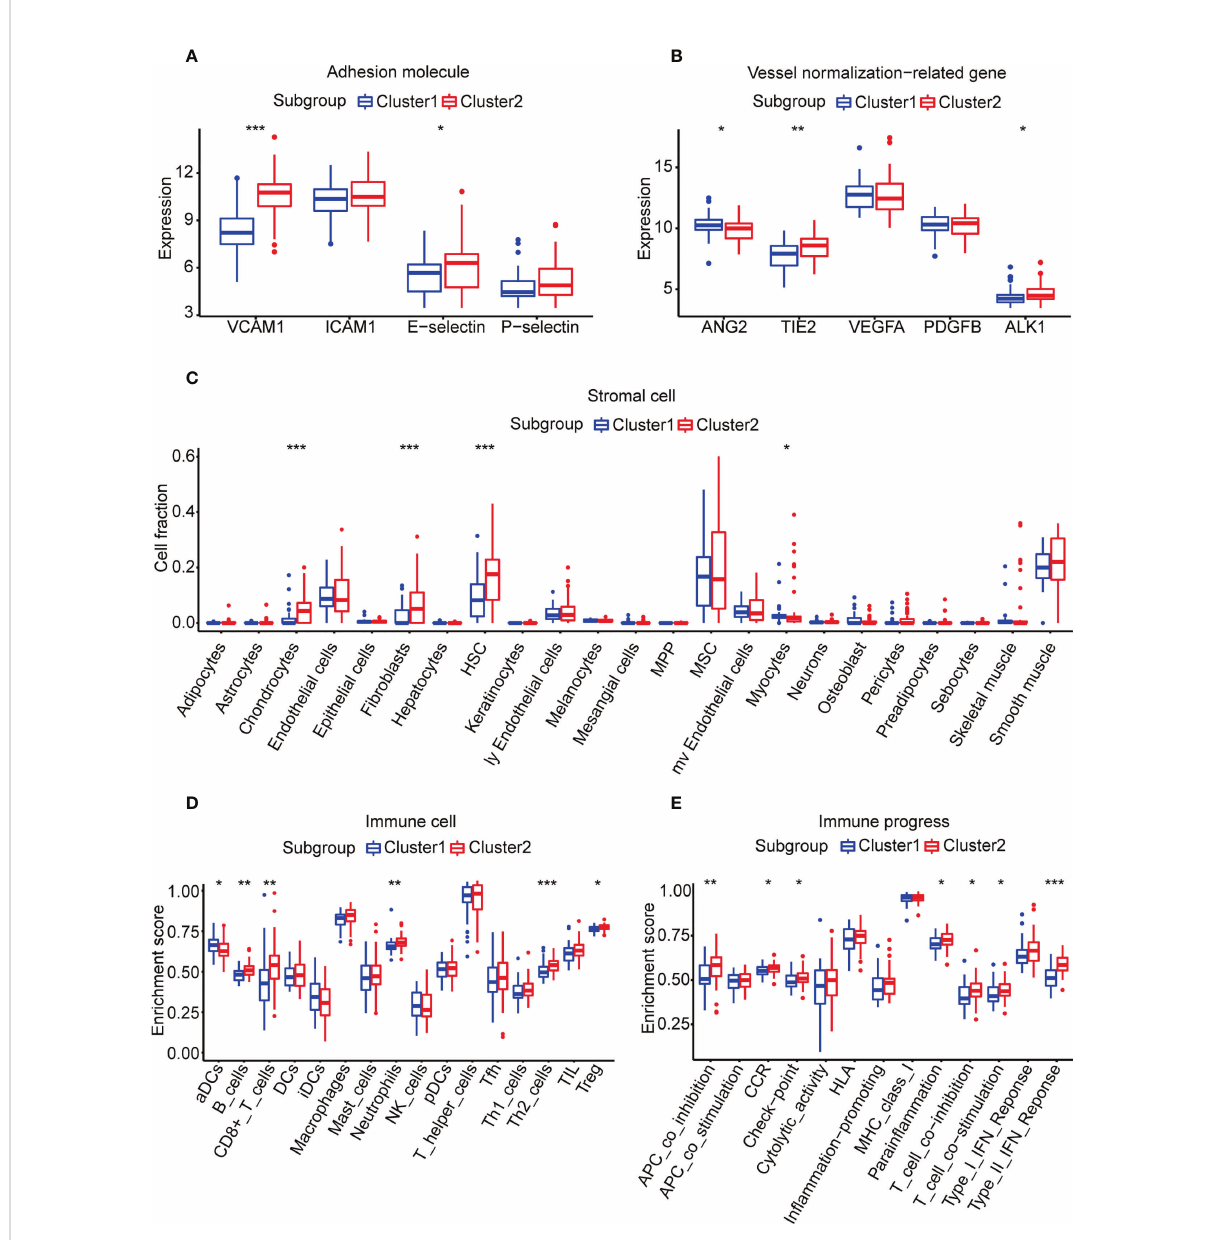
FIGURE 2 Vessel state and TME in the two subgroups. (A) Expression of adhesion molecules. (B) Expression of vessel normalization-related genes. (C) Enrichment scores of stromal cells calculated by xCell. (D, E) Enrichment scores of 29 immune cells and immune processes calculated by ssGSEA analysis. (* p < 0.05, ** p < 0.01, *** p <